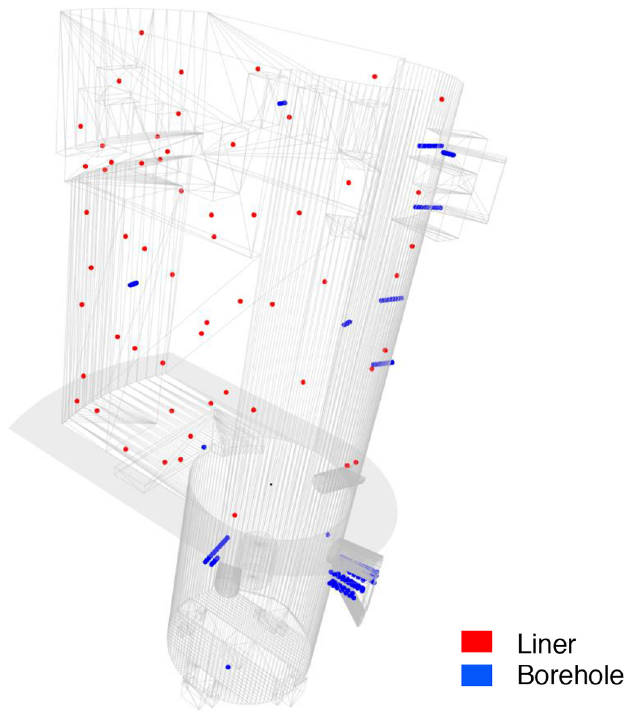
Fig. 1. Overview of the liner and borehole sample locations, corresponding to the measurement results used in the preliminary data